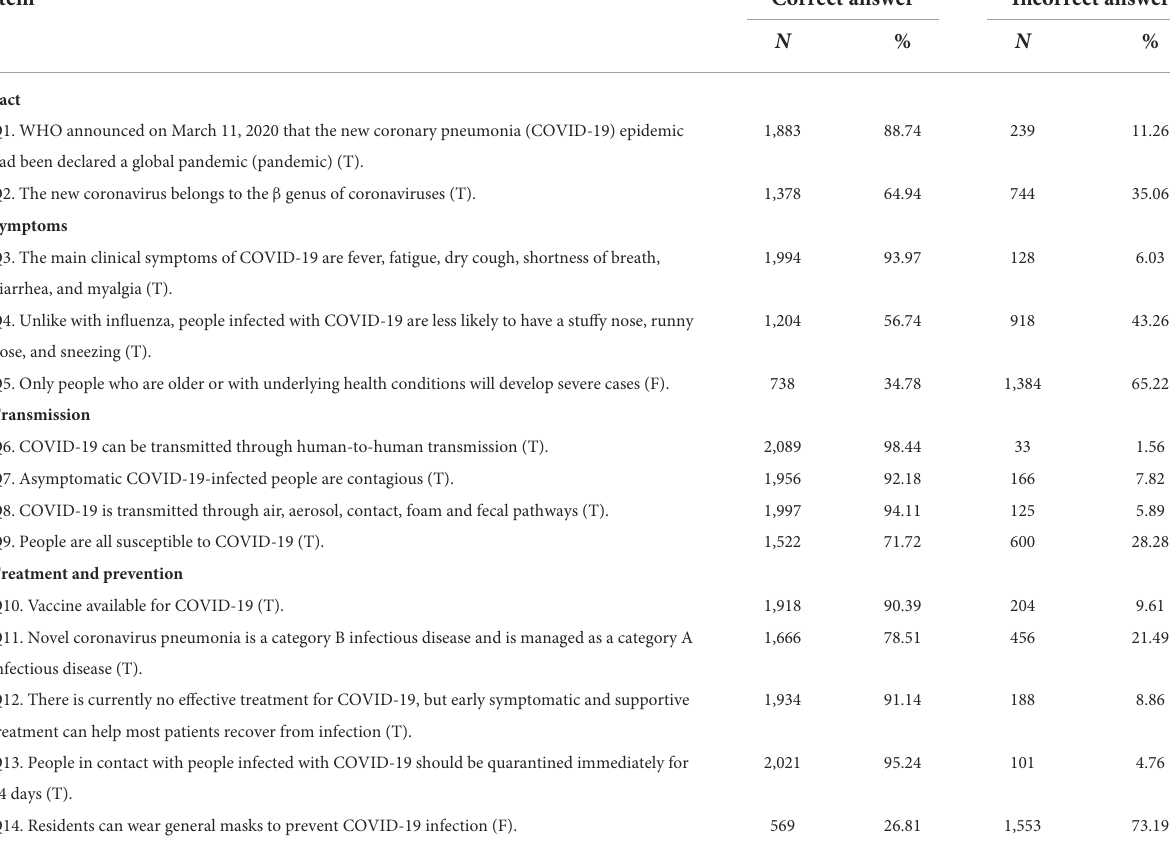
TABLE 2 Level of knowledge of COVID-19 ( N =